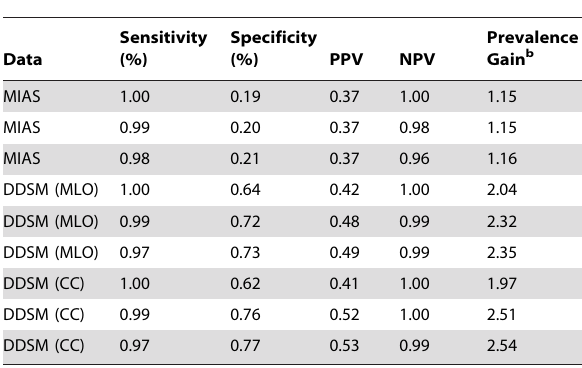
Table 2. Bayesian classifier performance a .